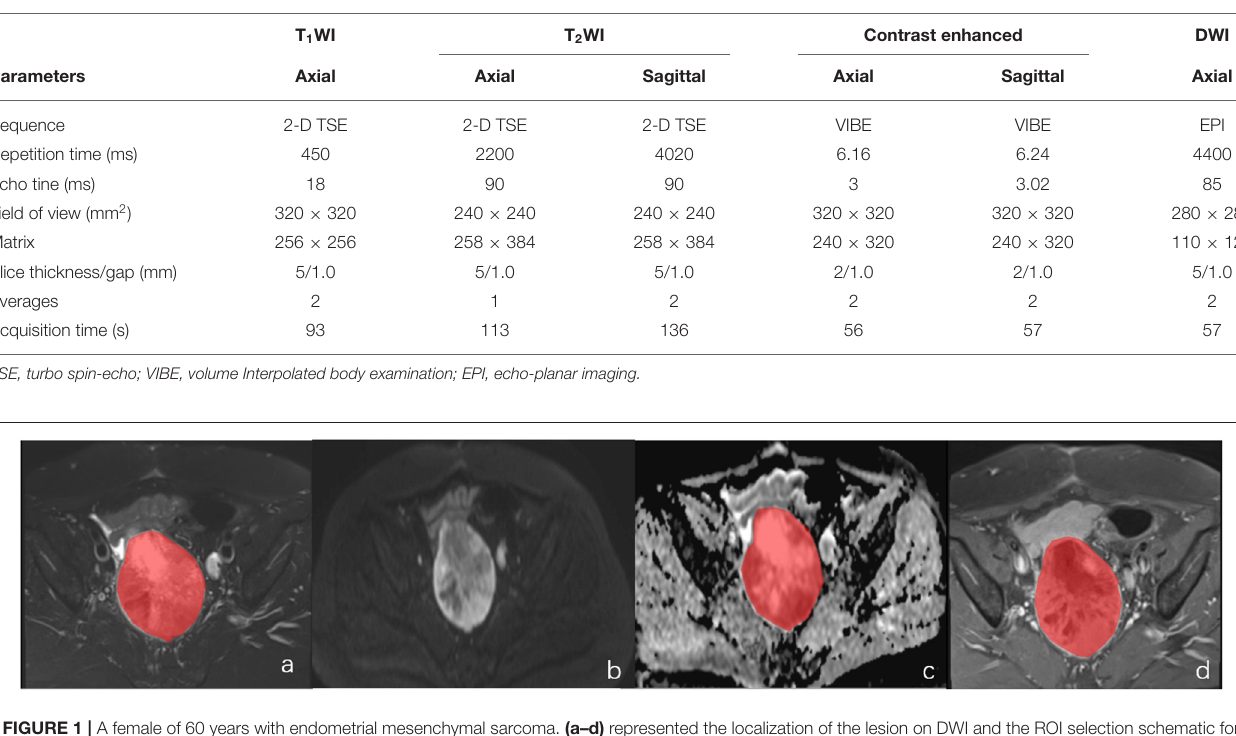
TABLE 2 | Imaging protocol for MRI sequences.